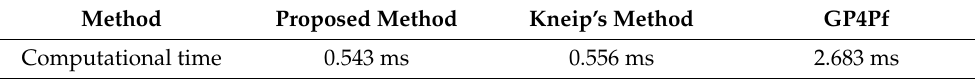
Table 1. Computational